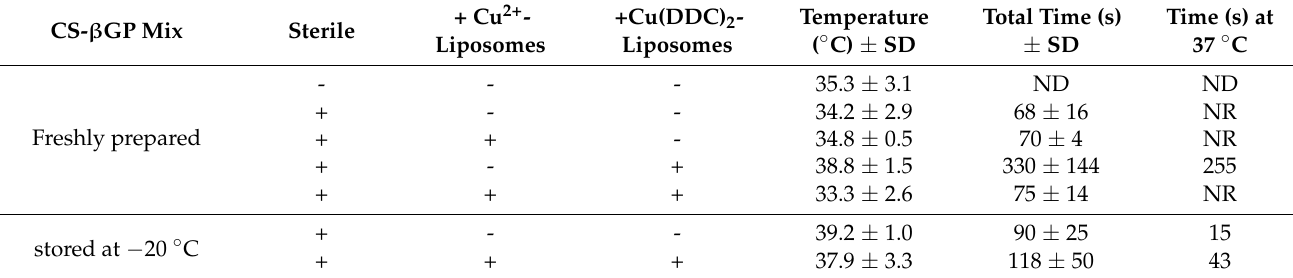
Table 2. Sol-gel transition temperature ( ◦ C) and time (s) of chitosan with β -glycerophosphate (CS- β GP; molar ratio 1:4.88). The sol-gel transition temperature and time were determined by rheological measurements of a temperature sweep and a time sweep mimicking an injection, respectively. During the temperature sweep, the temperature was increased from 15 to 45 ◦ C at a rate of 2 ◦ C/min. During the time sweep, the temperature was increased from 15 ◦ C to 37 ◦ C at maximum heating rate (within 75 s, mimicking an injection), and the time until sol-gel transition was either measured as total time (start point 15 ◦ C) or time at 37 ◦ C (start point 37 ◦ C). ND = not determined; NR = 37 ◦ C not reached. Data are expressed as mean ± standard deviation (n =